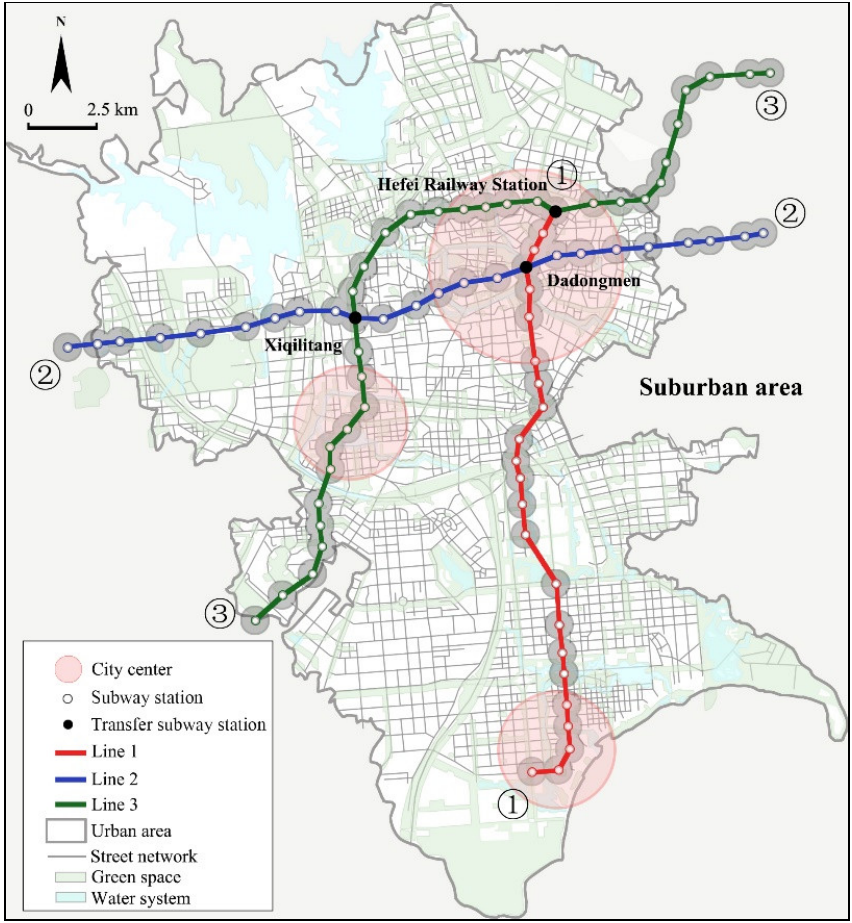
Figure 1. Map of the 77 TODs in Hefei City.